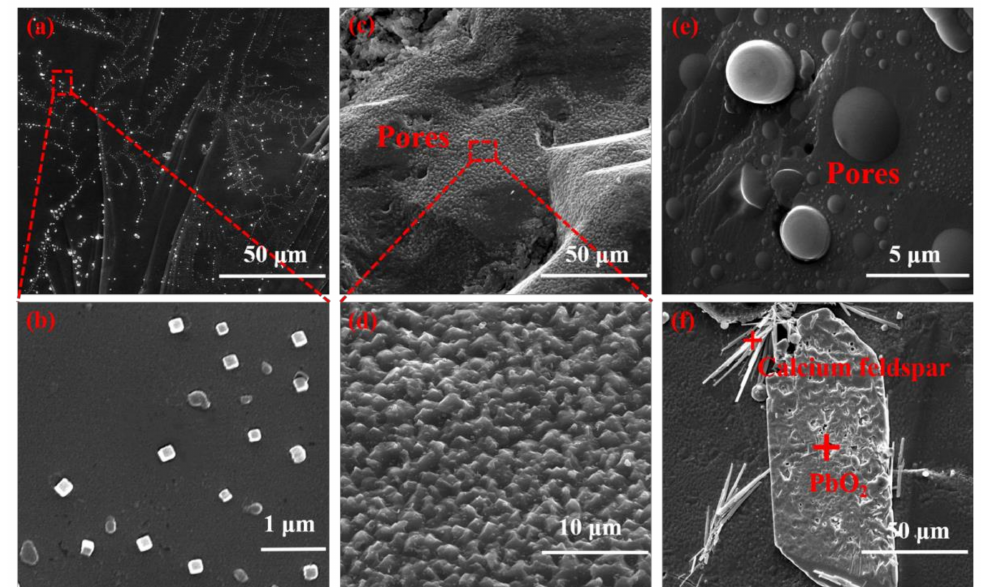
Figure 3. SEM image of pyrite sample. ( a – f ) SEM of pyrite samples: the image below is an enlarged version of the red rectangle. The morphology and material distribution on the surface of pyrite can be observed.